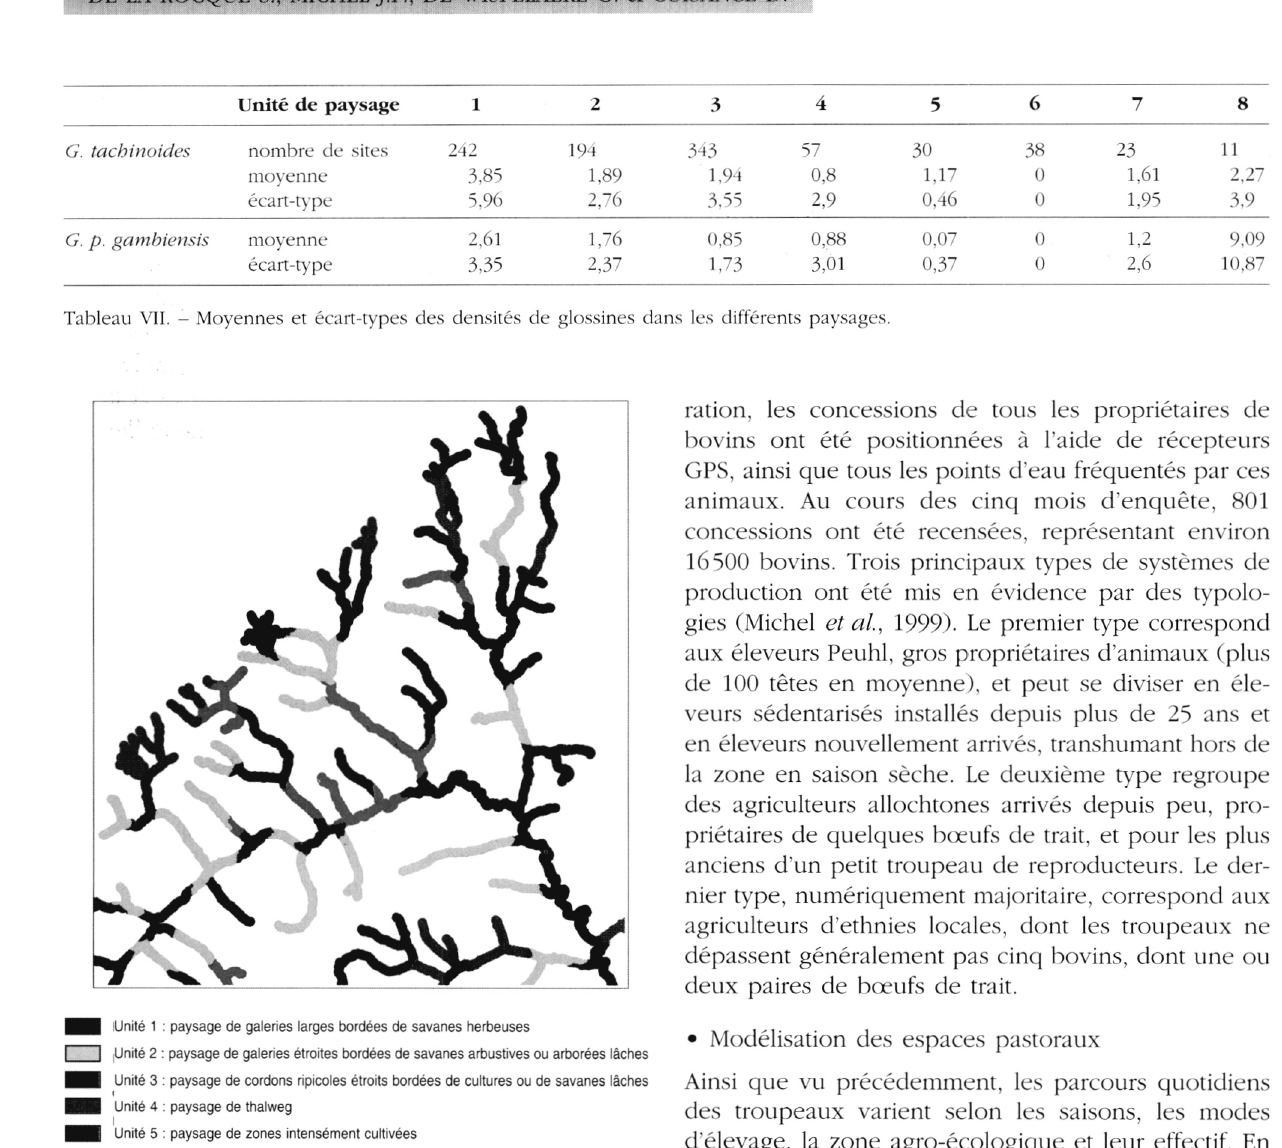
Fig. 16. - Distribution des différents paysages le long du réseau